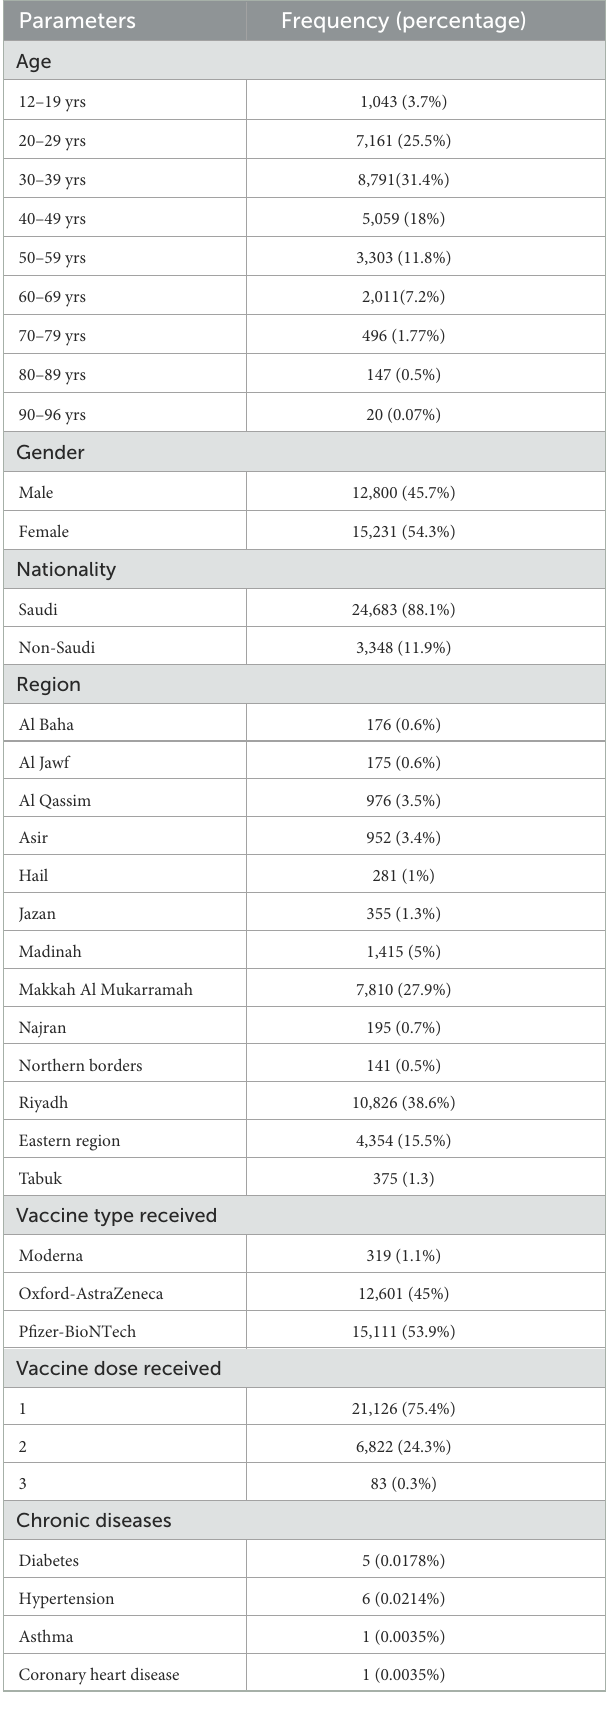
TABLE 1 Demographic characteristics of COVID-19 vaccine